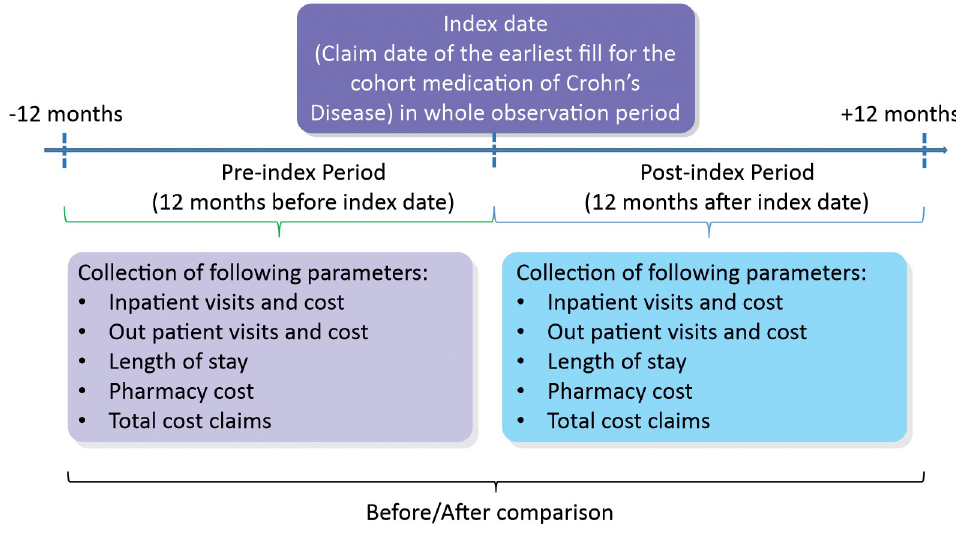
Fig 1. Mirror image study